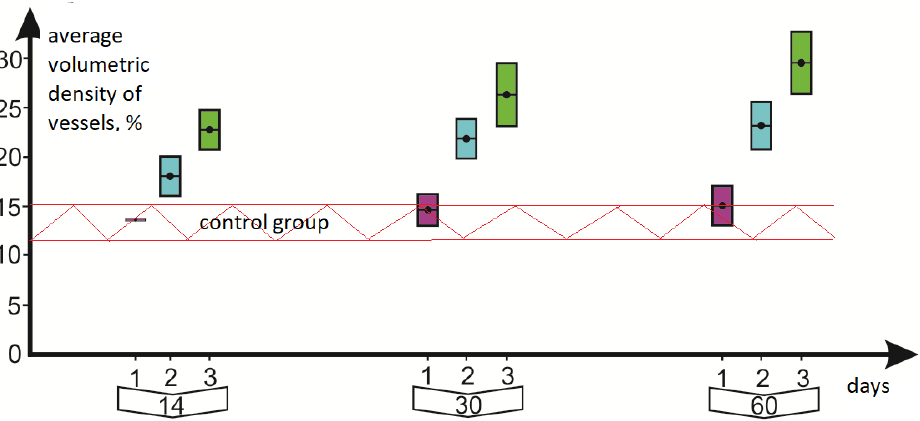
Figure 4. Change in the value of volumetric density of blood vessels in the investigated groups, depending on the time.